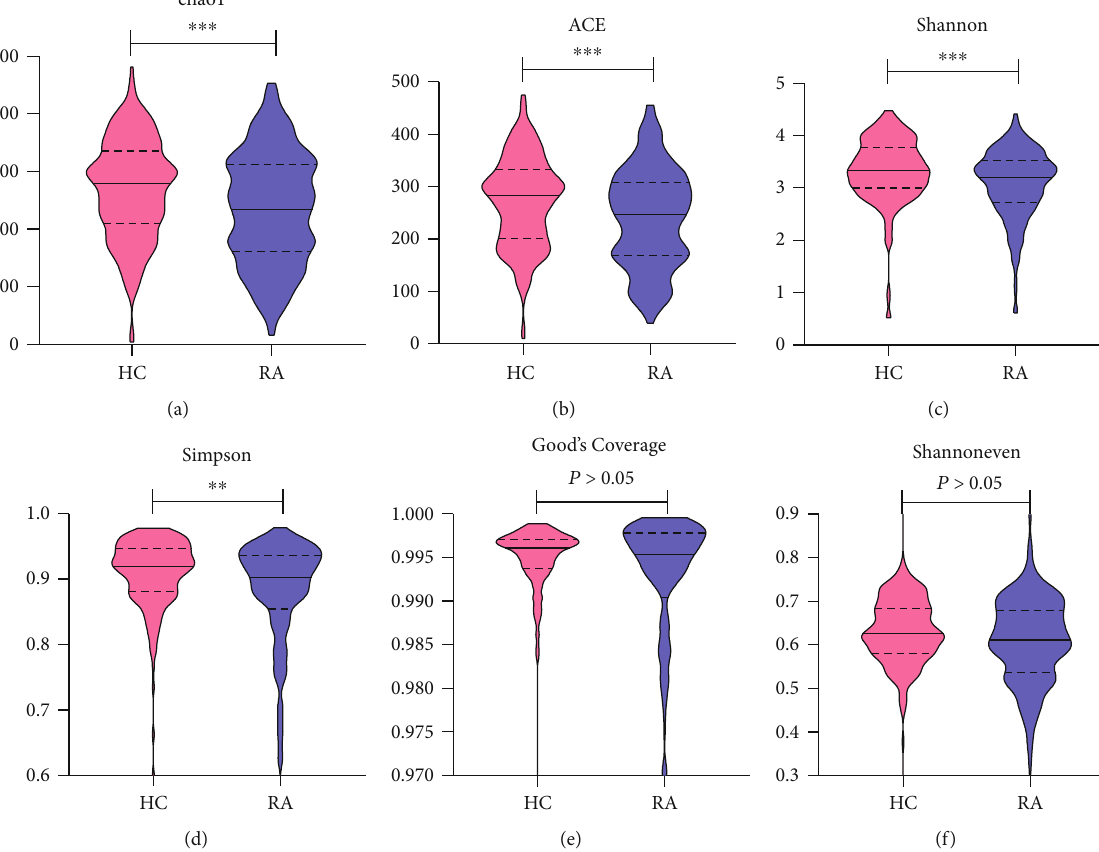
Figure 1: The α diversity of the gut microbiomes for the RA patients and the healthy controls has obvious di ff erences ( ∗∗∗ P < 0 : 001 , ∗∗ P < 0 : 01